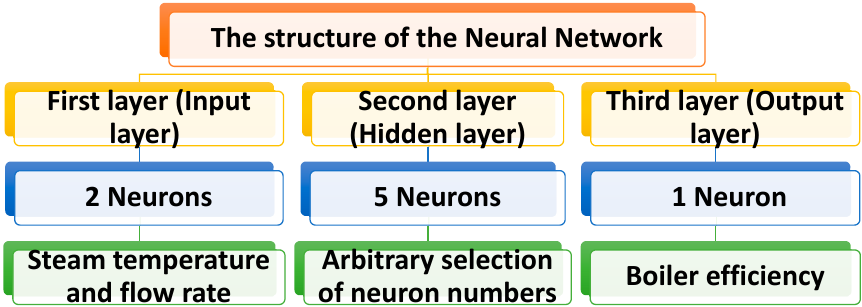
Figure 3. Triple layer neural network structure.